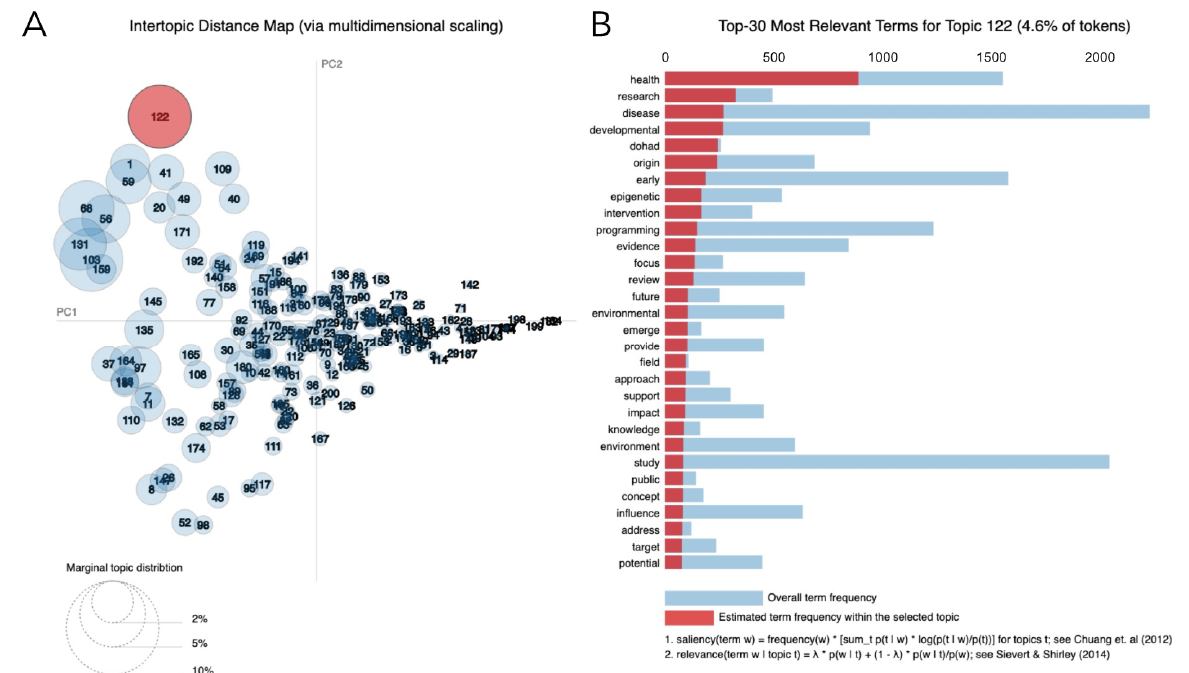
Figure 3. Results for text mining Model 1 for 200 topics via pyLDAvis. ( A ) PC plot and ( B ) histogram for 200-topic value from Model 1. ( A ) Each topic is represented as a circle (circle size = the frequency of terms that the topic spans over the entire corpus). The distance between circles (topics) indicates their (dis)similarity (closer = more similar). ( B ) The histogram displays the top 30 most relevant terms for the selected topic (in this example, the red circle in panel A ). The term frequency within that topic is represented by the horizontal red bars. The blue bars represent the frequency of the term across the whole corpus. PC1, principal component 1. PC2, principal component